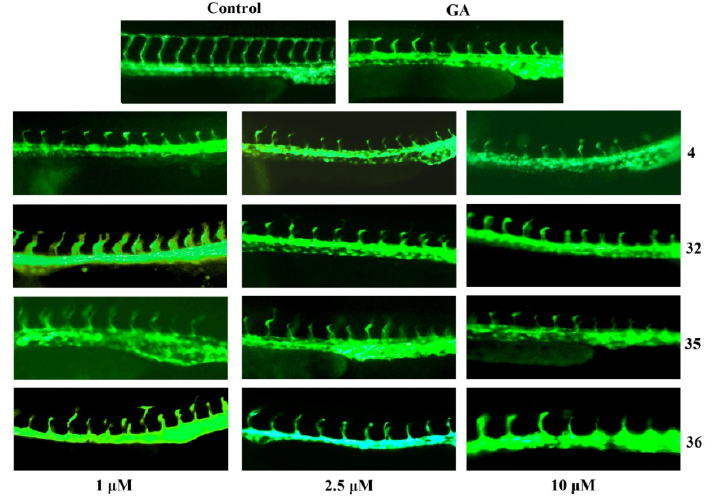
Figure 2. Effects of different concentrations of 4 , 32 , 35 , 36 on neovascularization in zebrafish embryos (Imager.Z1, magnification: 100×).